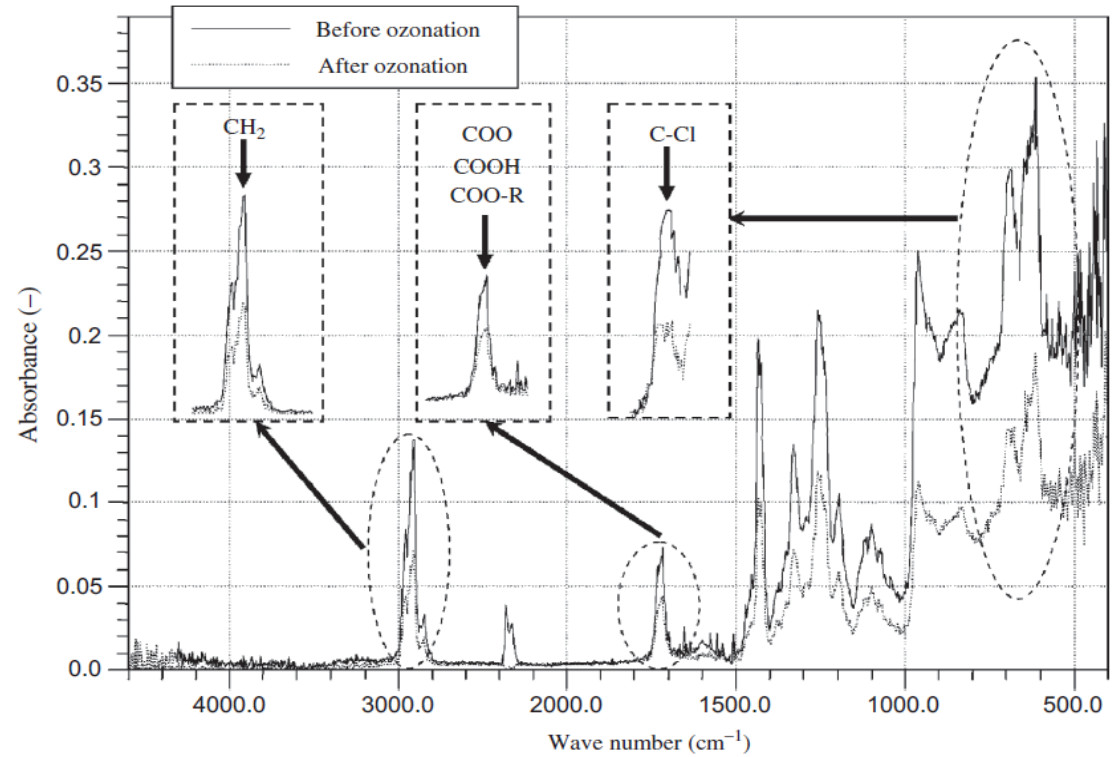
Figure 4. Fourier transform infrared spectra of the PVC sample before and after ozonation (Reprinted with permission from [75]. Copyright 2007 Taylor &